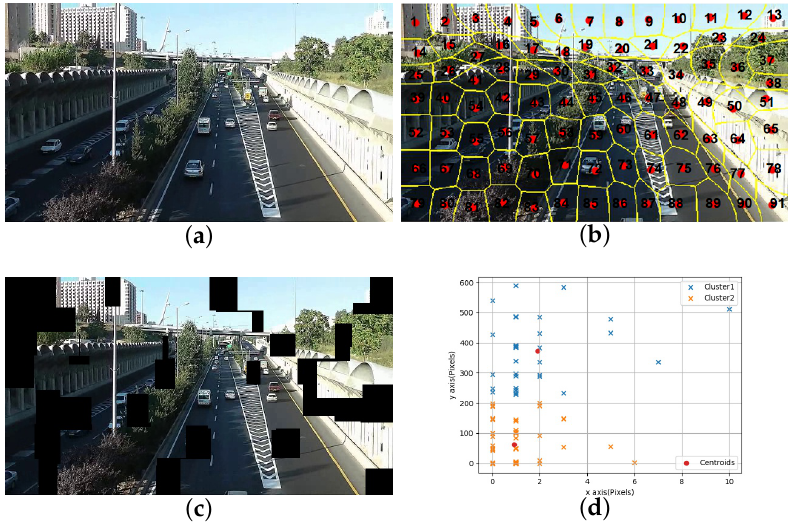
Figure 4. Experimental results of using superpixels to eliminate local motion blocks: ( a ) original image, ( b ) superpixel image, ( c ) the proposed method of local motion block removal, ( d ) motion vectors